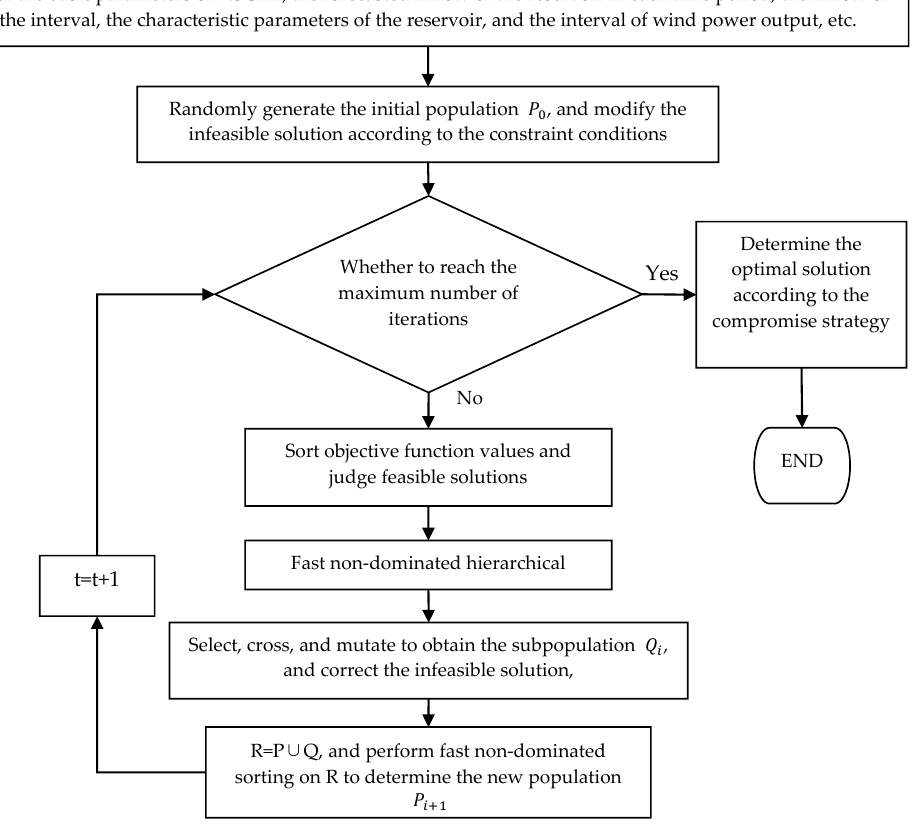
Figure 5. The process of using NSGA2 algorithm to solve the joint dispatching model.